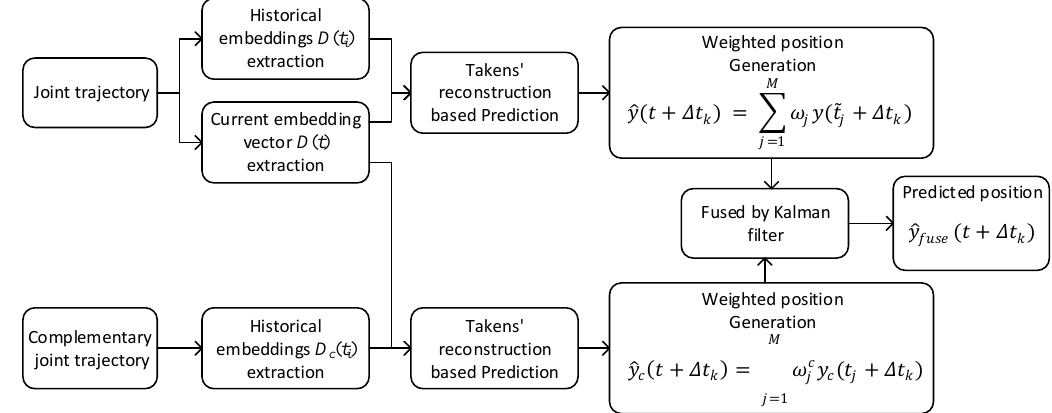
Figure 5. Synergy improvement method (2) of Takens’ reconstruction-based